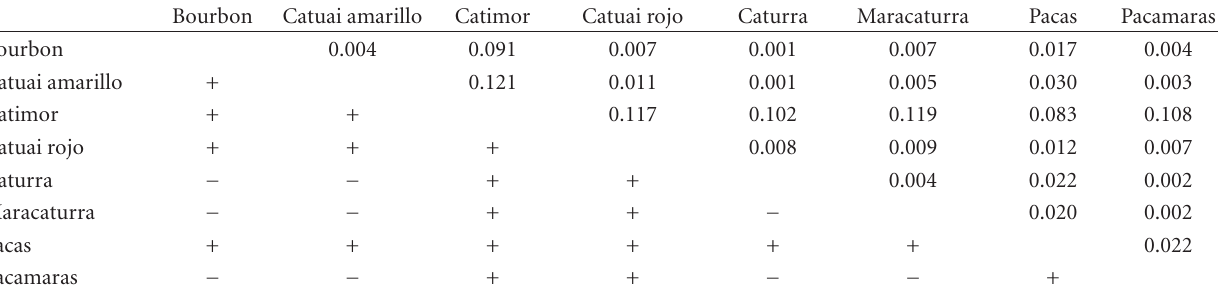
Table 6: The Nei’s standard genetic distance (above the diagonal) and the pairwise F ST (below the diagonal) between the eight arabica co ff ee varieties.